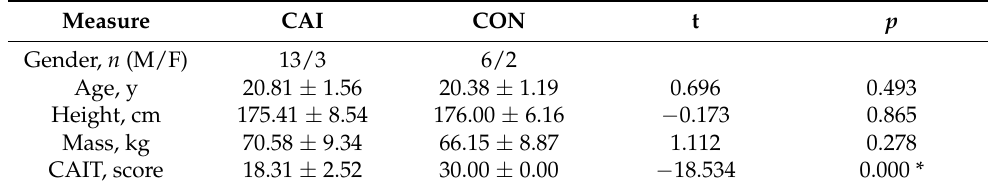
Table 1. Participant